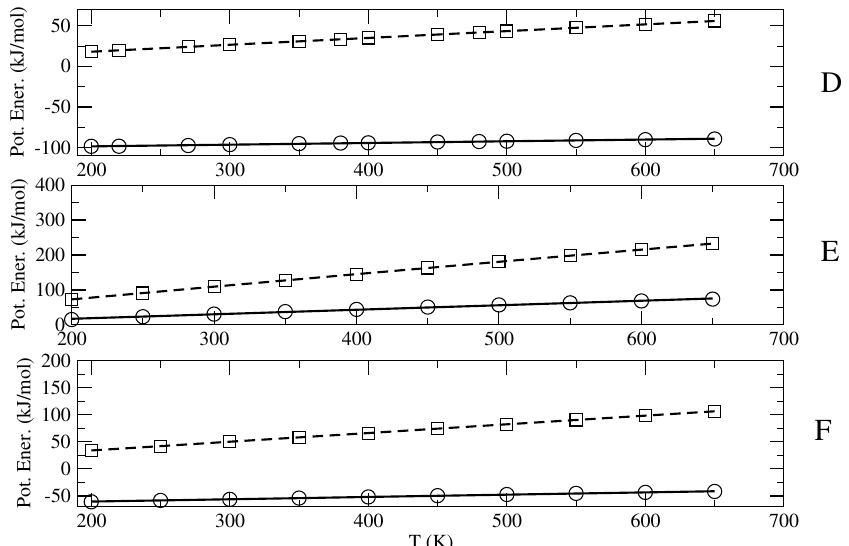
Figure 3. Plot of (cid:104)U pot , bending (cid:105) (squares) and (cid:104)U pot (cid:105) − (cid:104)U pot , bending (cid:105) (circles) as a function of the temperature, provided by the MD simulations of n-butanol ( D ), octadecane ( E ) and n-octane ( F ), as well as their quadratic and linear fittings (dashed and solid lines,